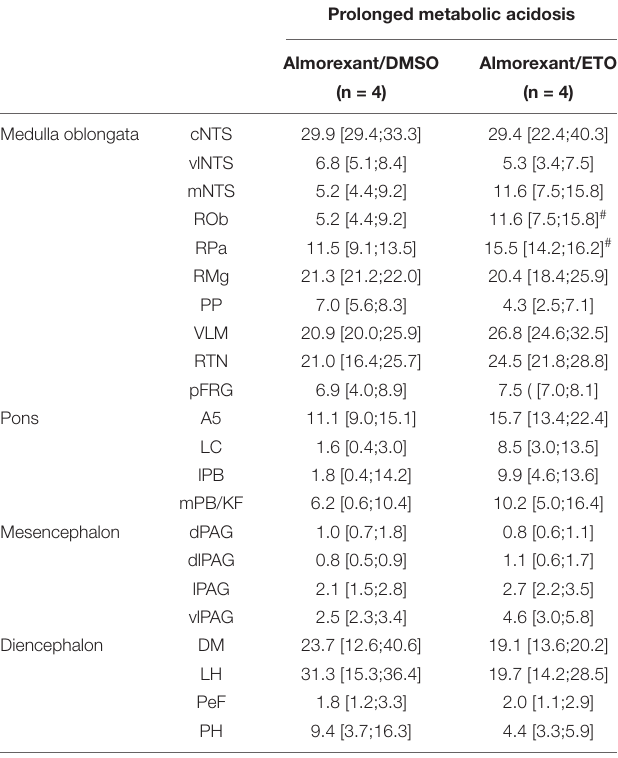
TABLE 2 | c-fos expression in brainstem and diencephalic structures of DBS ex vivo preparations under prolonged metabolic acidosis condition in the presence of almorexant/DMSO and